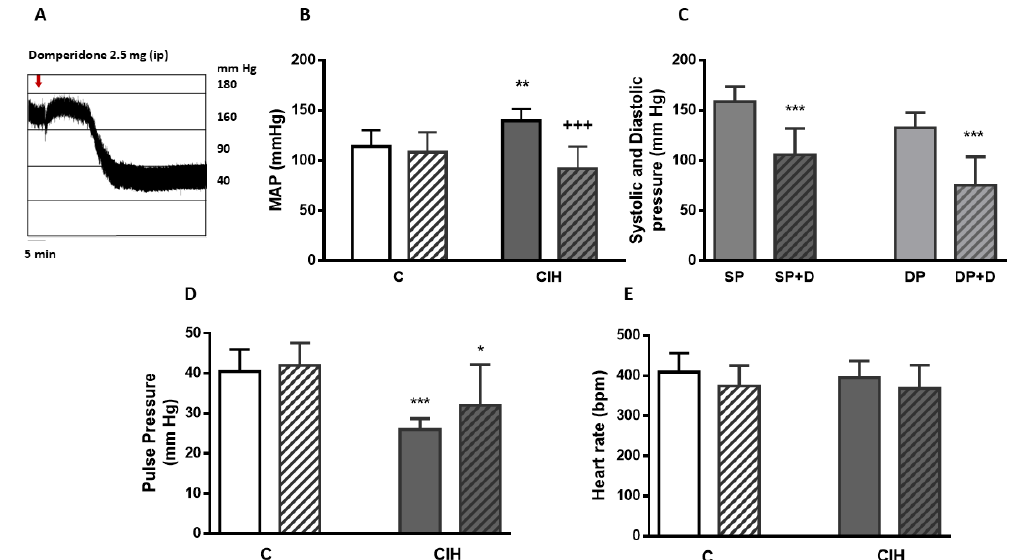
Figure 1. Acute effect of domperidone on arterial blood pressure. Effect of DOM (2mg/kg —1 ; ip) on C and CIH rats. ( A ) shows a single blood pressure recording from a CIH rat. ( B ) represents mean arterial blood pressure (MAP) from C animals (white bar) and the acute effect of DOM (striped bar), and MAP from CIH (gray bar) and the acute effect of DOM (gray striped bar). ** p < 0.01 vs. C; +++ p < 0.001 vs. CIH. Data are represented as mean and SD from 6—9 animals; Two-way Anova with Sidak's multiple comparisons test. ( C ) shows systolic and diastolic pressure from CIH animals before (SP and DP) and after administration of DOM (SP+D and DP+D); *** p < 0.001 SP vs. SP+D; +++ p < 0.001 DP vs. DP + D represented as mean and SD from 9 rats. Two-way Anova with Sidak's multiple comparisons test. In ( D , E ) pulse pressure and heart rate from the C and CIH before and after DOM administration (CD and CIHD) are shown. Data are mean and SD from 6–9 rats.